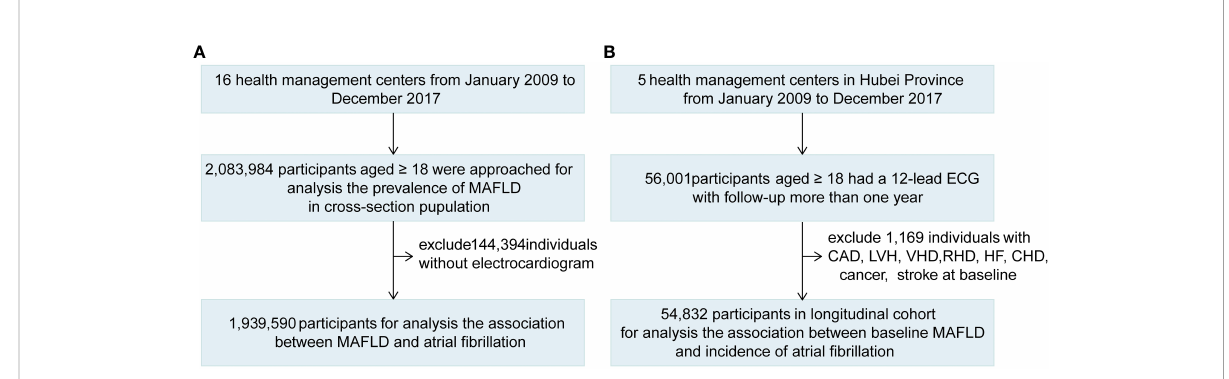
FIGURE 1 The Flowchart Showing the Strategy of Participant Enrollment. A schematic overview illustrating participants enrollment and the exclusion and inclusion criteria. (A) The fl owchart of the cross-sectional study. (B) The fl owchart of the